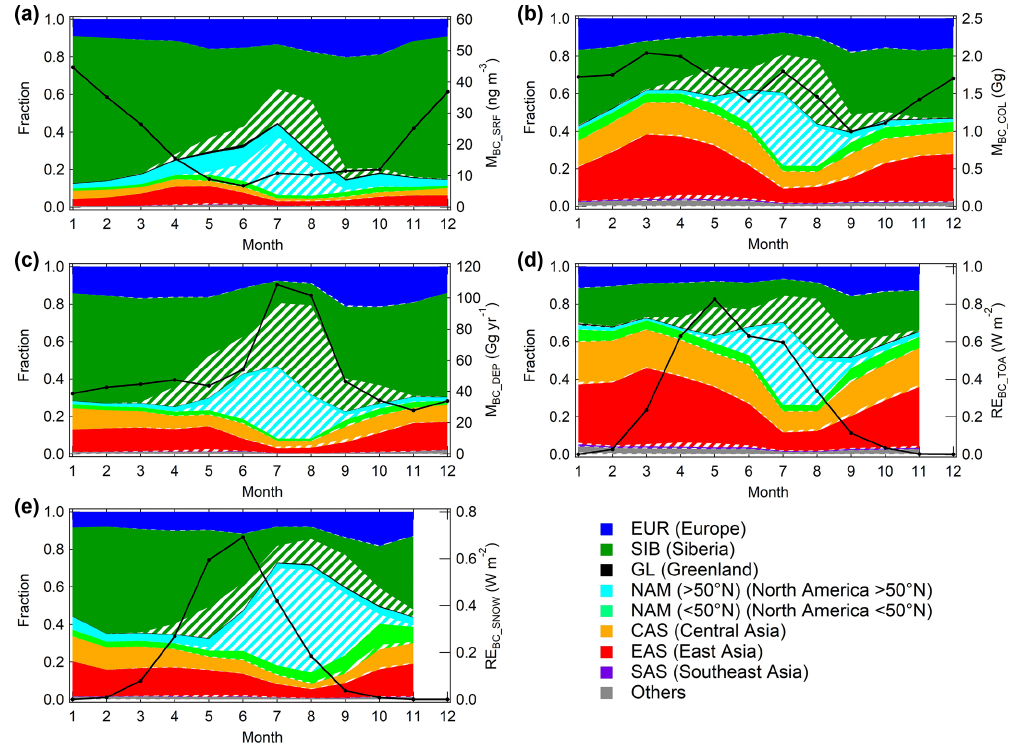
Figure 8. Monthly variations of source contributions to (a) M BC_SRF , (b) M BC_COL , (c) M BC_DEP , (d) RE BC_TOA , and (e) RE BC_SNOW in the Arctic. The filled and shaded areas indicate contributions from anthropogenic and biomass burning sources, respectively. The black lines (right axis) show total BC concentrations, deposition flux, or radiative effects from all